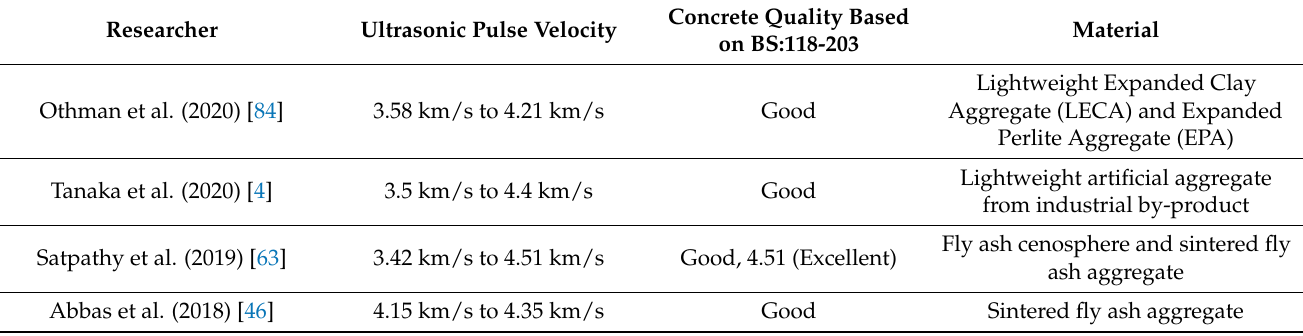
Table 6. Previous studies on ultrasonic pulse velocity of lightweight aggregate